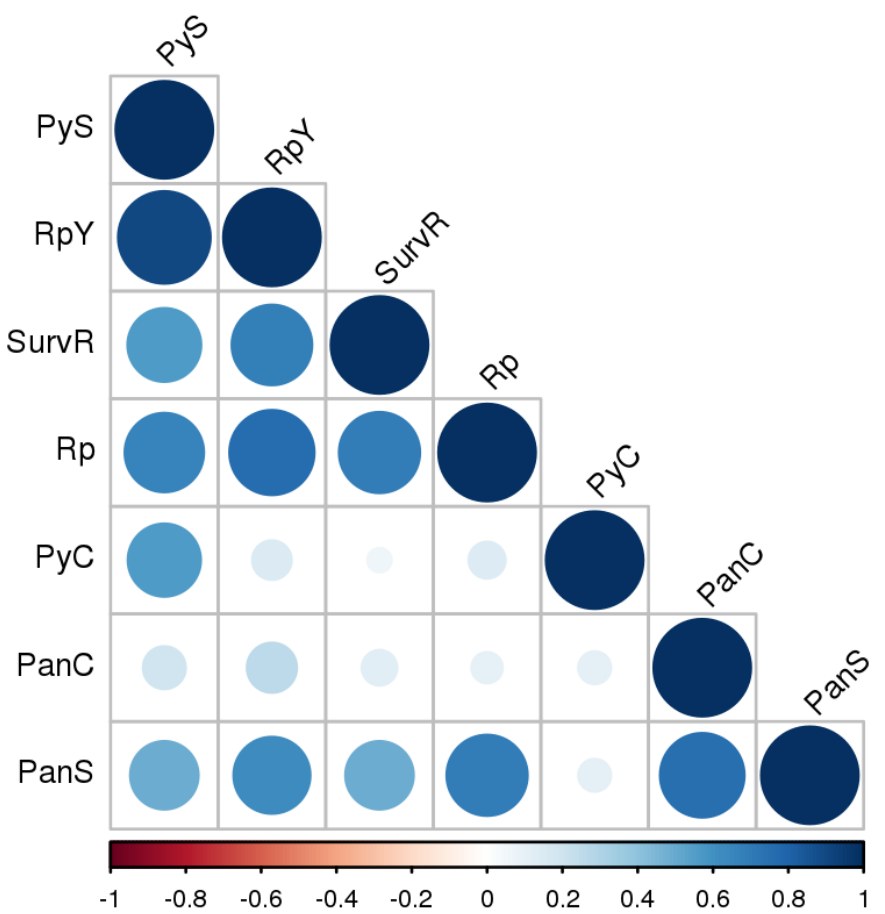
Figure 3. Correlation matrix for survival rate (SurvR): panicles in control (PanC), panicles in saline (PanS), relative panicles (Rp), paddy yield in control (PyC), paddy yield in saline (PyS), and relative paddy yield (RpY).